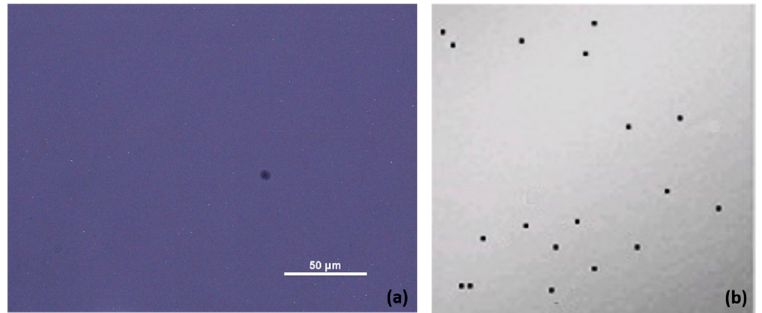
Figure 10. IR micrographs obtained from ( a ) THM grown Cd 0.9 Zn 0.1 Te 0.97 Se 0.02 crystal and ( b ) a VBM grown Cd 0.9 Zn 0.1 Te 0.97 Se 0.03 crystal. The scan covered an area of ~1.1 × 1.5 mm 2 . The images have been cropped for better visibility (Adapted with permission from ref. [49]. Copyright 2021, IEEE).